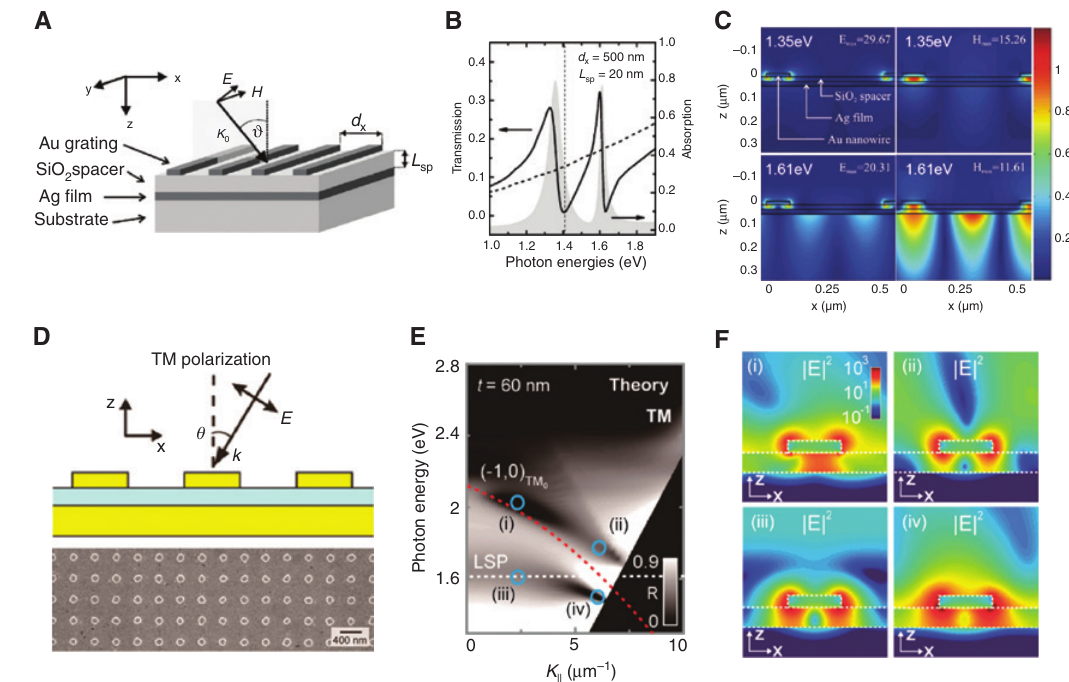
Figure 7: Two examples of multiresonant plasmonic systems based on the optical coupling between localized plasmonic modes and delocalized plasmonic